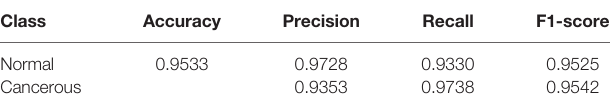
TABLE 3 | Performance of patch-level classi fi of features